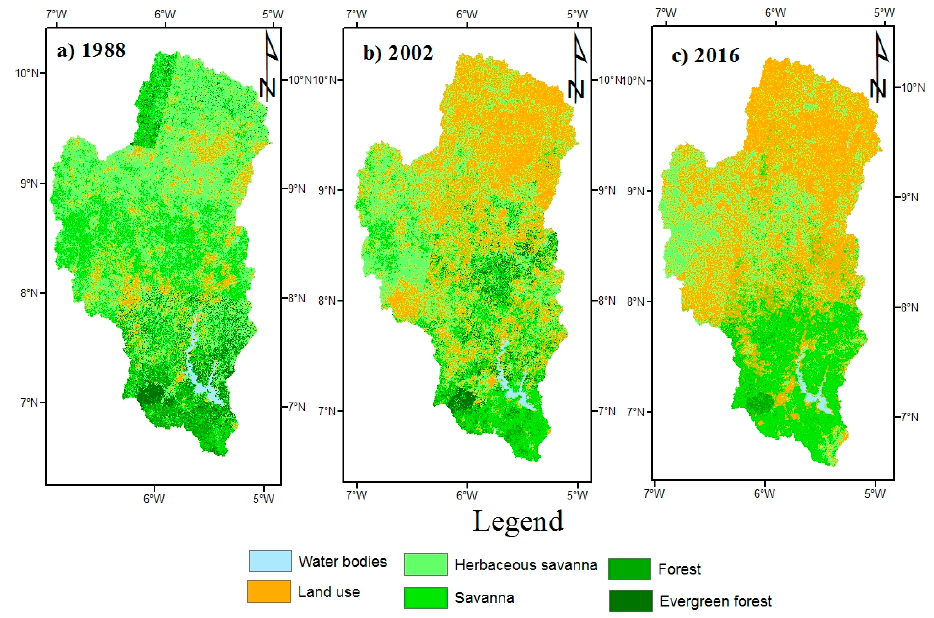
Figure 3. Bandama Basin land use and land cover maps.